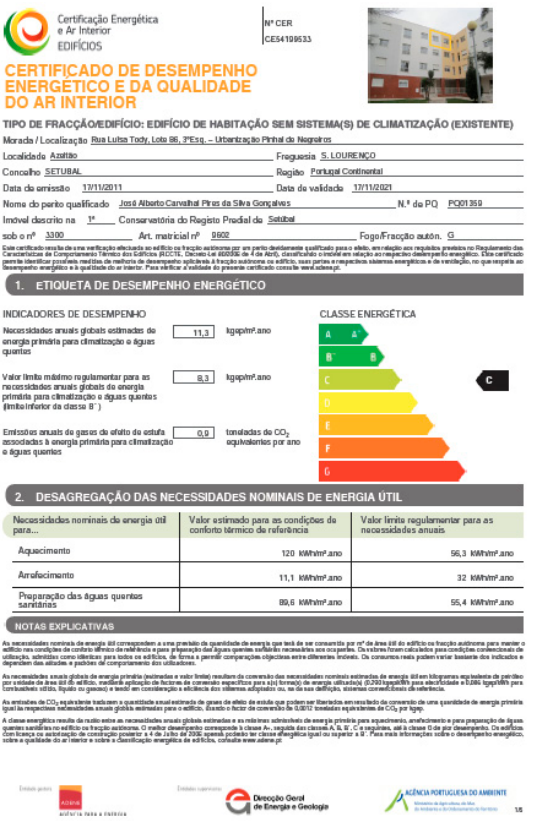
Figure 12. Example of a Portuguese Energy Performance certificate (SCE Decree 78/2006).